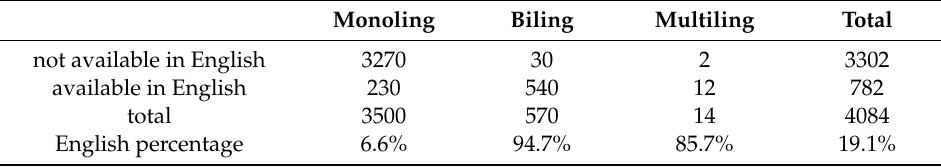
Table A54. English language availability